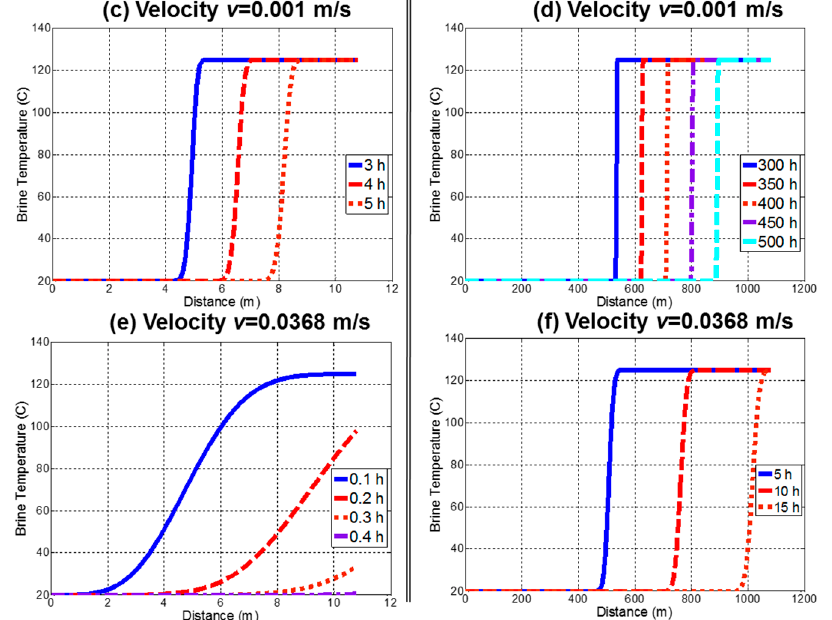
Figure 14. Brine temperature profiles at different distances from the injection point in the fracture. The short-term ( left ) and long-term ( right ) heating profiles are shown for three different velocities. ( a , b ) v = 0.0001 m/s, ( c , d ) v = 0.001 m/s, and ( e , f ) 0.0368 m/s.